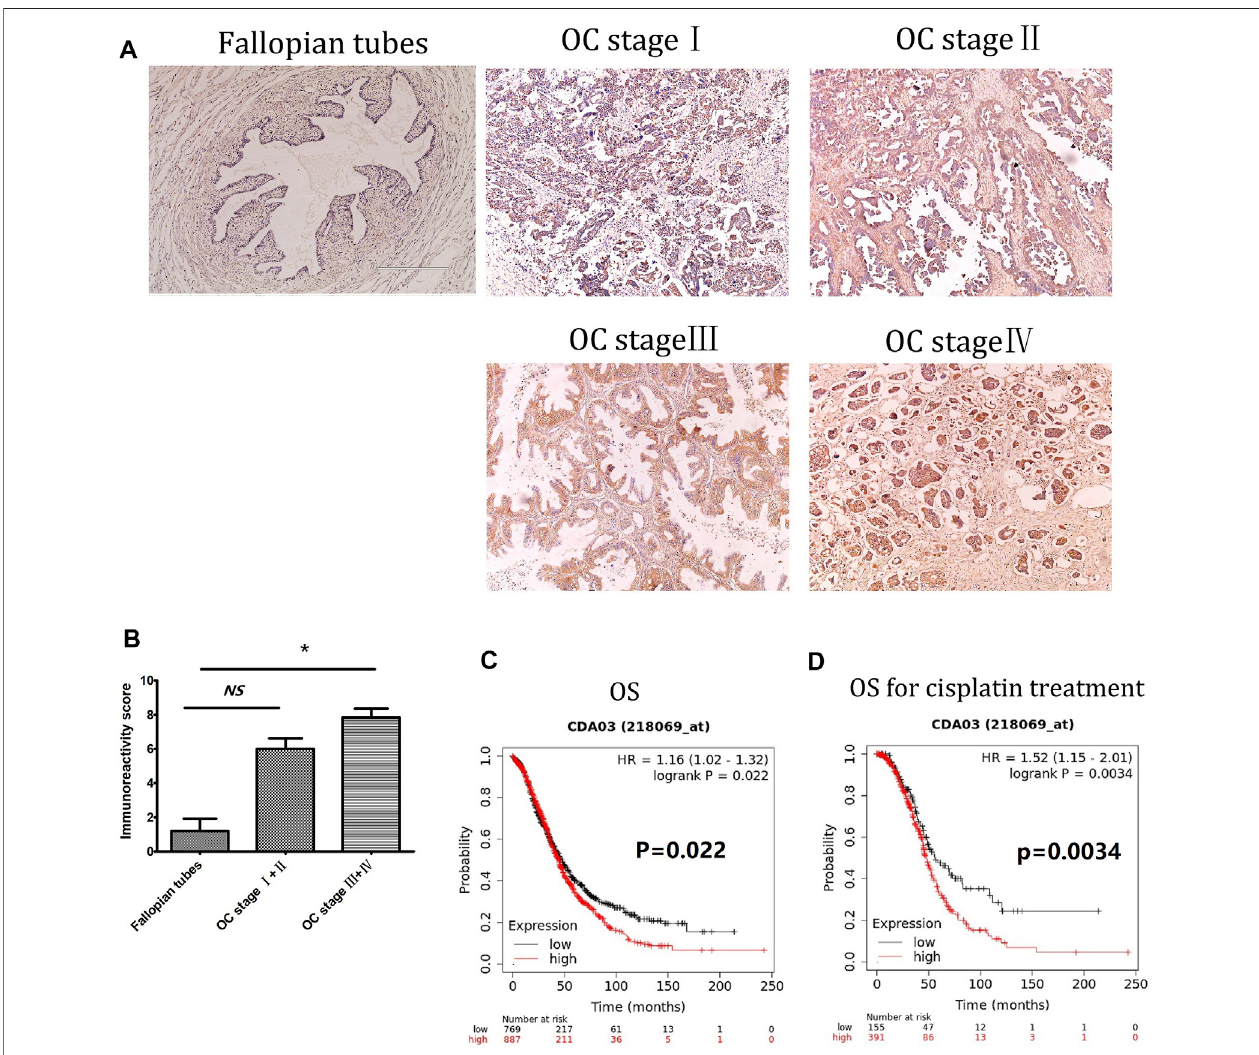
FIGURE 1 | Overexpression of DCTPP1 is a poor prognostic marker in ovarian cancer. (A) Immunohistochemistry staining of DCTPP1 on human Fallopian tubes and ovarian cancer tissues. (B) Scoring of DCTPP1 staining in human ovarian cancer tissues with different pathological grade (Fallopian tubes, stage Ⅰ + Ⅱ , stage Ⅲ + Ⅳ ).*, p < 0.05; ns, no signi fi cance. (C) Kaplan-Meier analysis of overall survival (OS) in ovarian cancer patients based on DCTPP1 expression level. (D) Kaplan-Meier analysis of overall survival (OS) in ovarian cancer patients with cisplatin treatment based on DCTPP1 expression level.